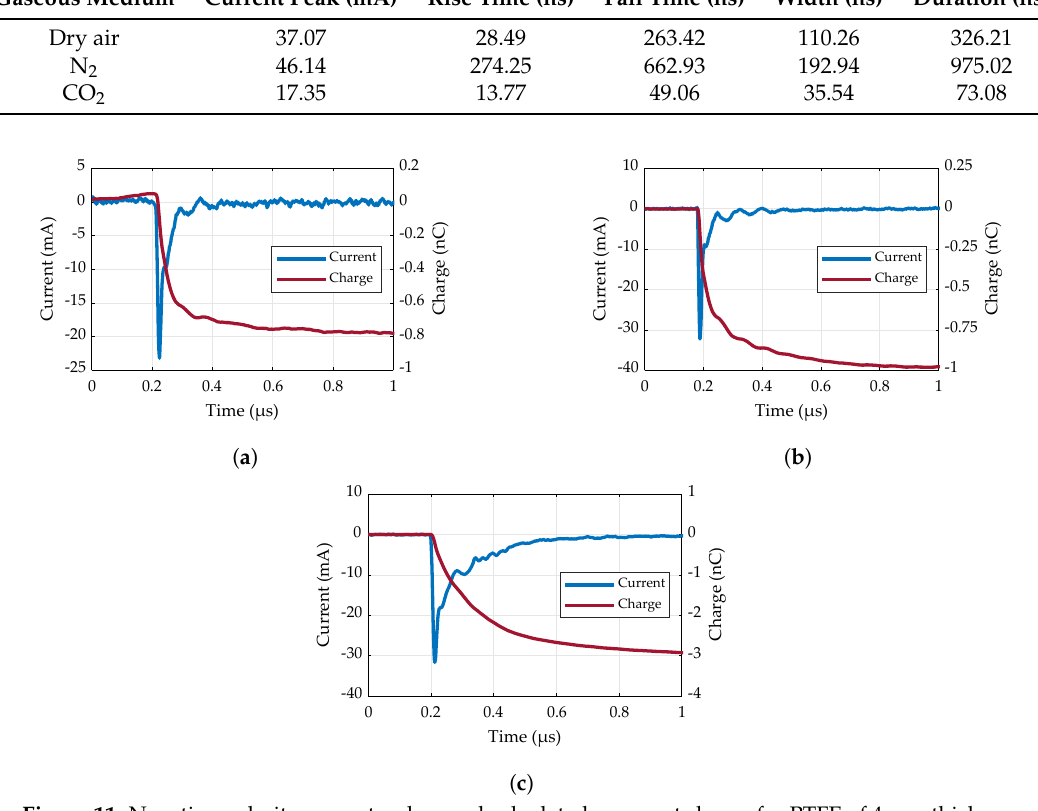
Figure 11. Negative polarity current pulses and calculated apparent charge for PTFE of 4mm thickness